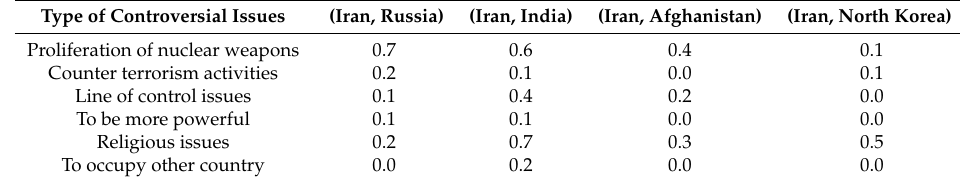
Table 8. Fuzzy set of controversial issues between Iran and other countries.